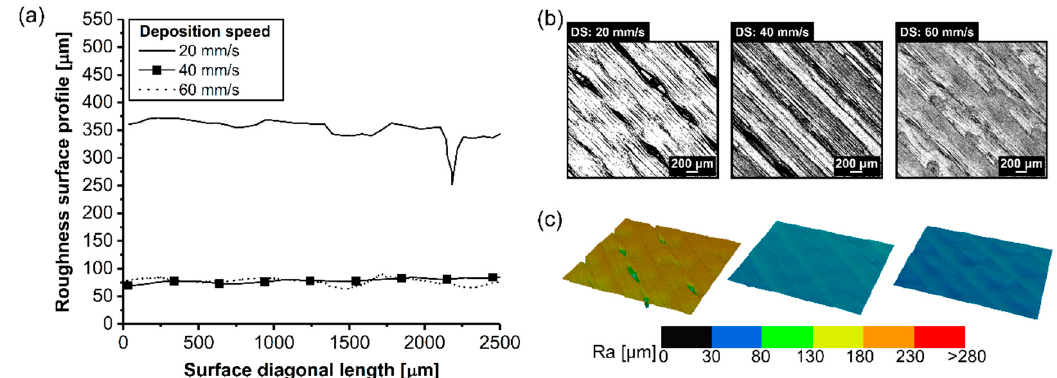
Figure 14. Influence of the surface roughness on the 3D ‐ printed ABS for different deposition speeds ( a ) roughness surface profile, ( b ) surface image, and ( c ) 3D ‐ image from the surface (condition six, DS: 20 mm/s; condition four, DS: 40 mm/s; condition seven, DS: 60 mm/s; the following parameters PT: 280 °C, RT: 0.1 mm, AC: 15 wt.%, and NC: 2 were fixed for the conditions investigated).